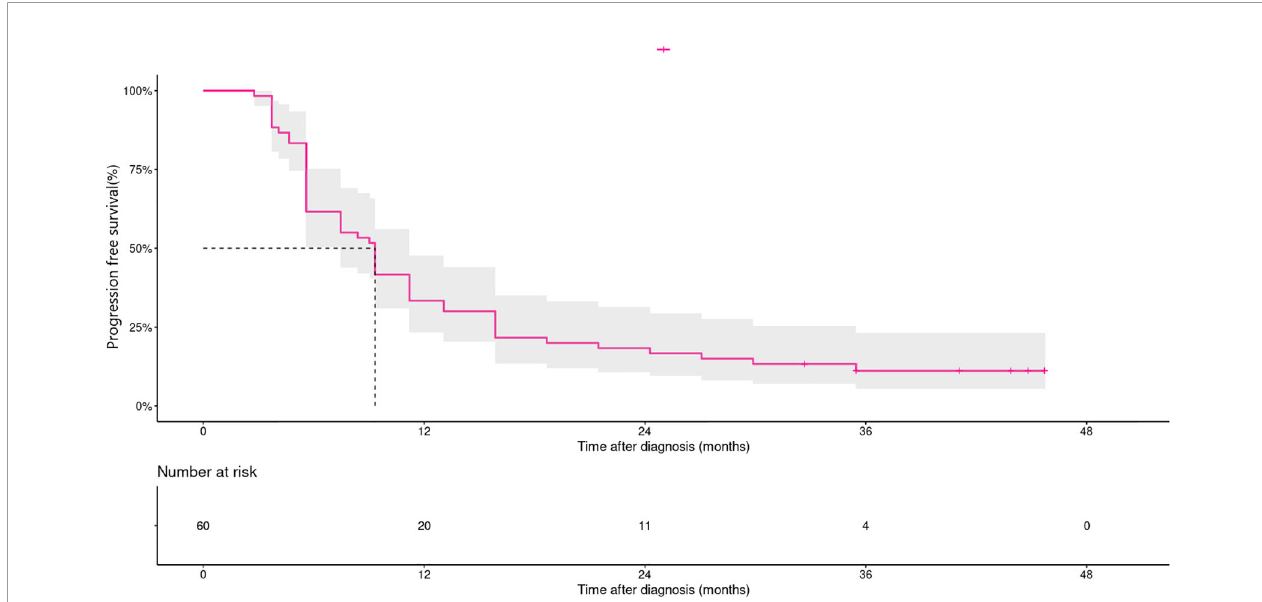
FIGURE 1 | Kaplan – Meier curves for progression-free survival in patients treated with dabrafenib and trametinib (n=60). Median PFS and 3 year-PFS rates were 9.3 month (95% CI, 8.4 – 10.3) and 11.1% (95% CI, 3.3 – 18.9%), respectively.